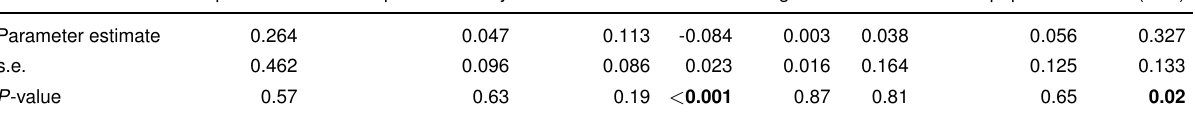
Table 2. Results of a Generalized Least Squares model controlling for spatial autocorrelation, for the proportion of agricul- tural land under organic farming in French Departments (2008) as a function of plant biodiversity, landscape connectivity, proportion of Natura 2000 protected areas, latitude, longitude, altitude, human population size and department area. The number of data points is 95, the Akaike Criterion Indicator of the model 59.9, and the intercept 1.457 (s.e. = 1.972). N of plant taxa Landscape connectivity % Natura 2000 Latitude Longitude Altitude Human population Area (km 2 )